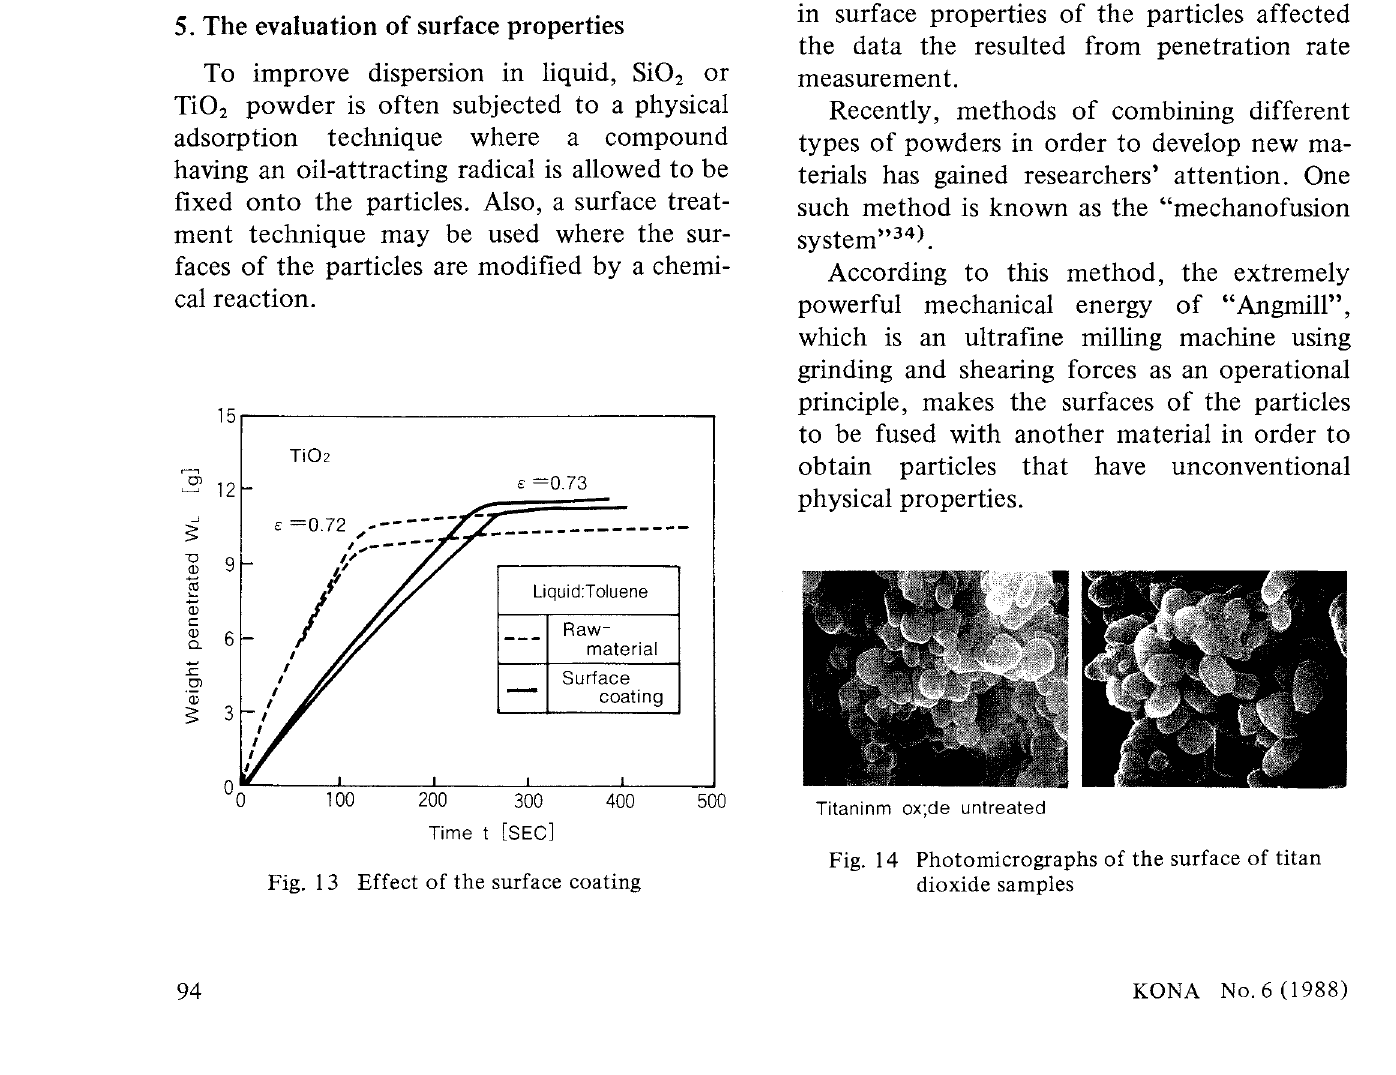
Fig. 14 Photomicrographs of the surface of